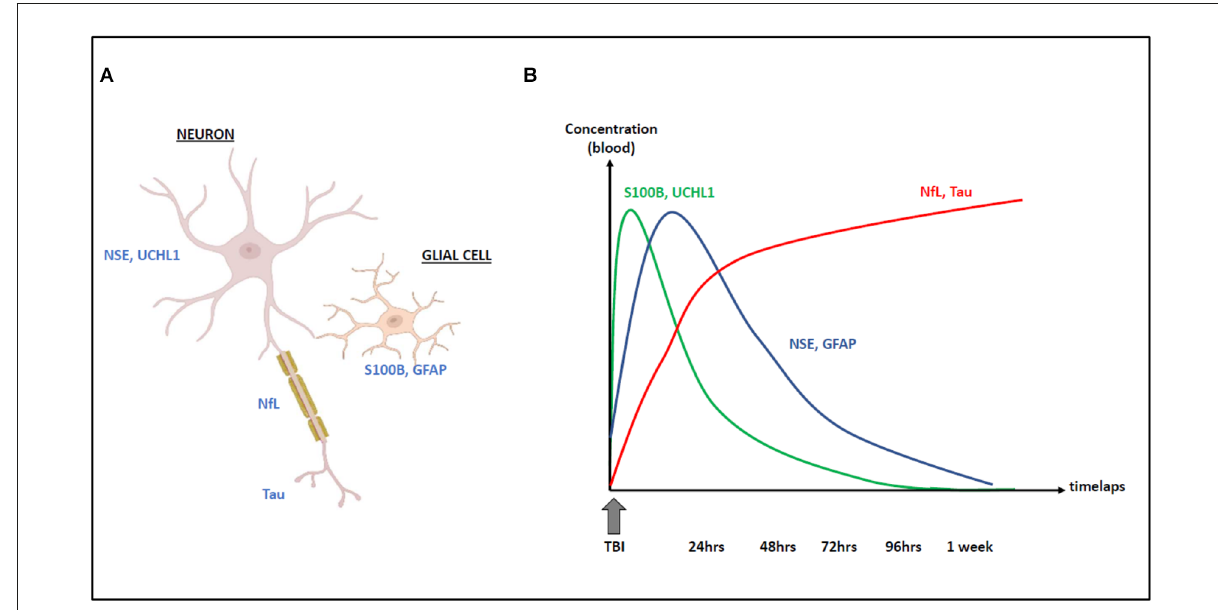
FIGURE3 Cellular origin (A) and kinetics (B) of NfL increase following traumatic brain injury (TBI) compared with other biomarkers: S100B, UCH-L1, Tau, NSE, and